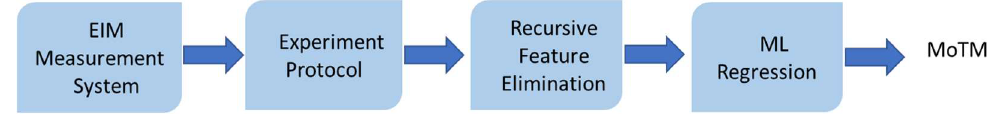
Figure 1. The framework of this study. A measurement system is used to measure the parameters of EIM for the muscles of lower limb. According to the experiment protocol, we recruited ninety-six subjects. RFE is used to select the important features to estimate the total MoTM by the ML models.